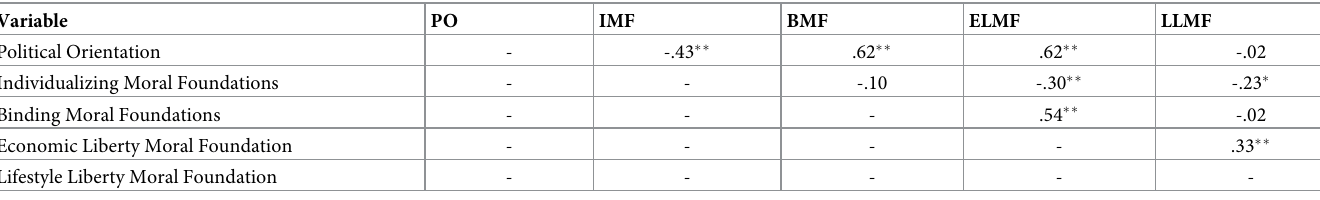
Table 3. Correlation matrix for key political and moral variables (n = 209). Variable